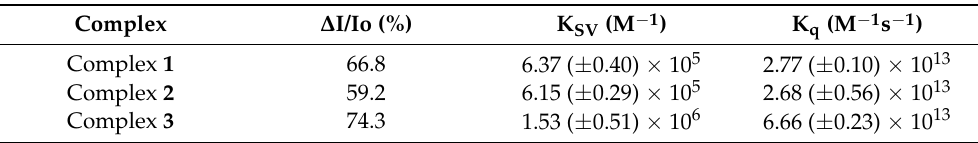
EDTA, BHT, NDGA, and trolox were purchased from Sigma-Aldrich Co. (St. Louis, MO, USA). NaCl, KOH and trisodium citrate were purchased from Merck (Rahway, NJ, USA). Sodium diclofenac was purchased from Tokyo Chemical Industry and diflunisal from Fluka (Buchs, Switzerland). The reagents for the evaluation of the cholinergic activity: 5,5-dithio- bis-(2-nitrobenzoic acid) (DTNB), electric eel acetylcholinesterase (eeAChE), acetylthio- choline iodide (ATCI), equine serum butyrylcholinesterase (eqBuChE), S-butyrylthiocholine iodide (BTCI), and neostigmine methyl sulfate (Neo) were purchased from J&K Scientific Co. (Beijing, China). Ascorbic acid, Na 2 HPO 4 , and NaH 2 PO 4 were purchased from Chem- lab Co. (Zedelgem, Belgium). All the chemical reagents and all solvents were of